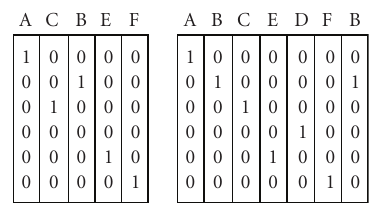
Figure 1: Time-series matrices X and Y .